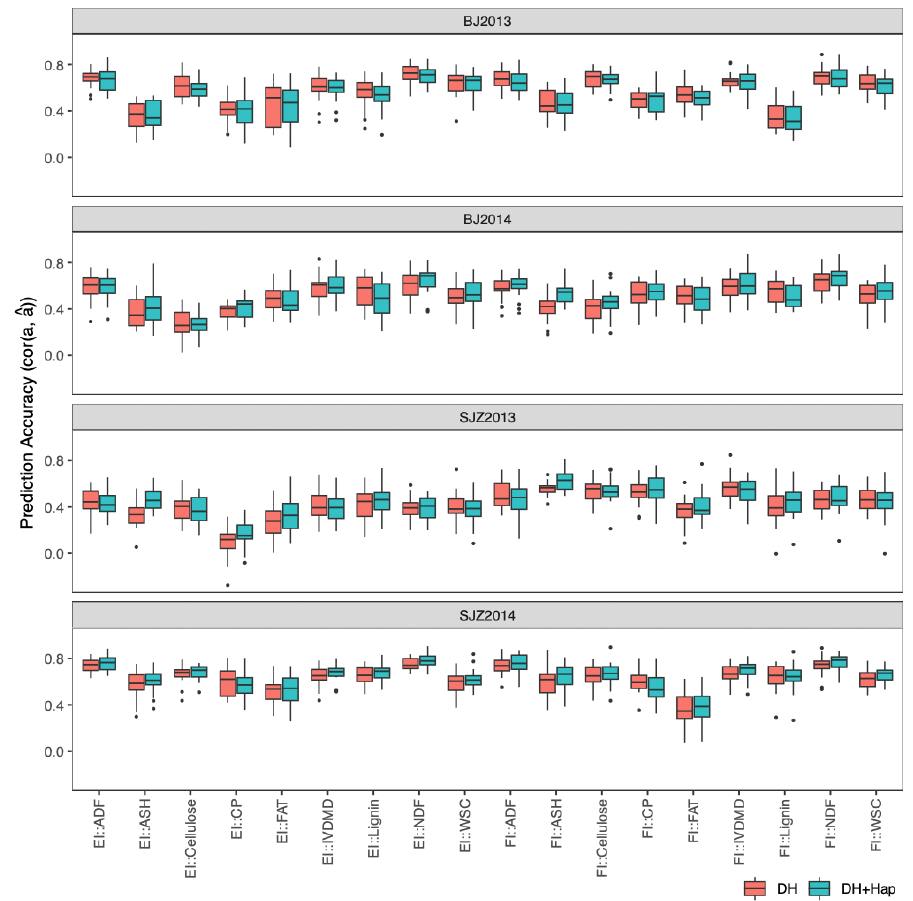
Figure 5. Distribution of prediction accuracies of the 18 stalk quality traits of the DH population across 20 resampling runs estimated by multi-trait models with MegaLMM in single-environment trials. The corrected resampled t-test was applied to test difference in prediction accuracy between DH- population-based (DH-based) and DH and haploid populations-based (DH + Hap-based) genomic